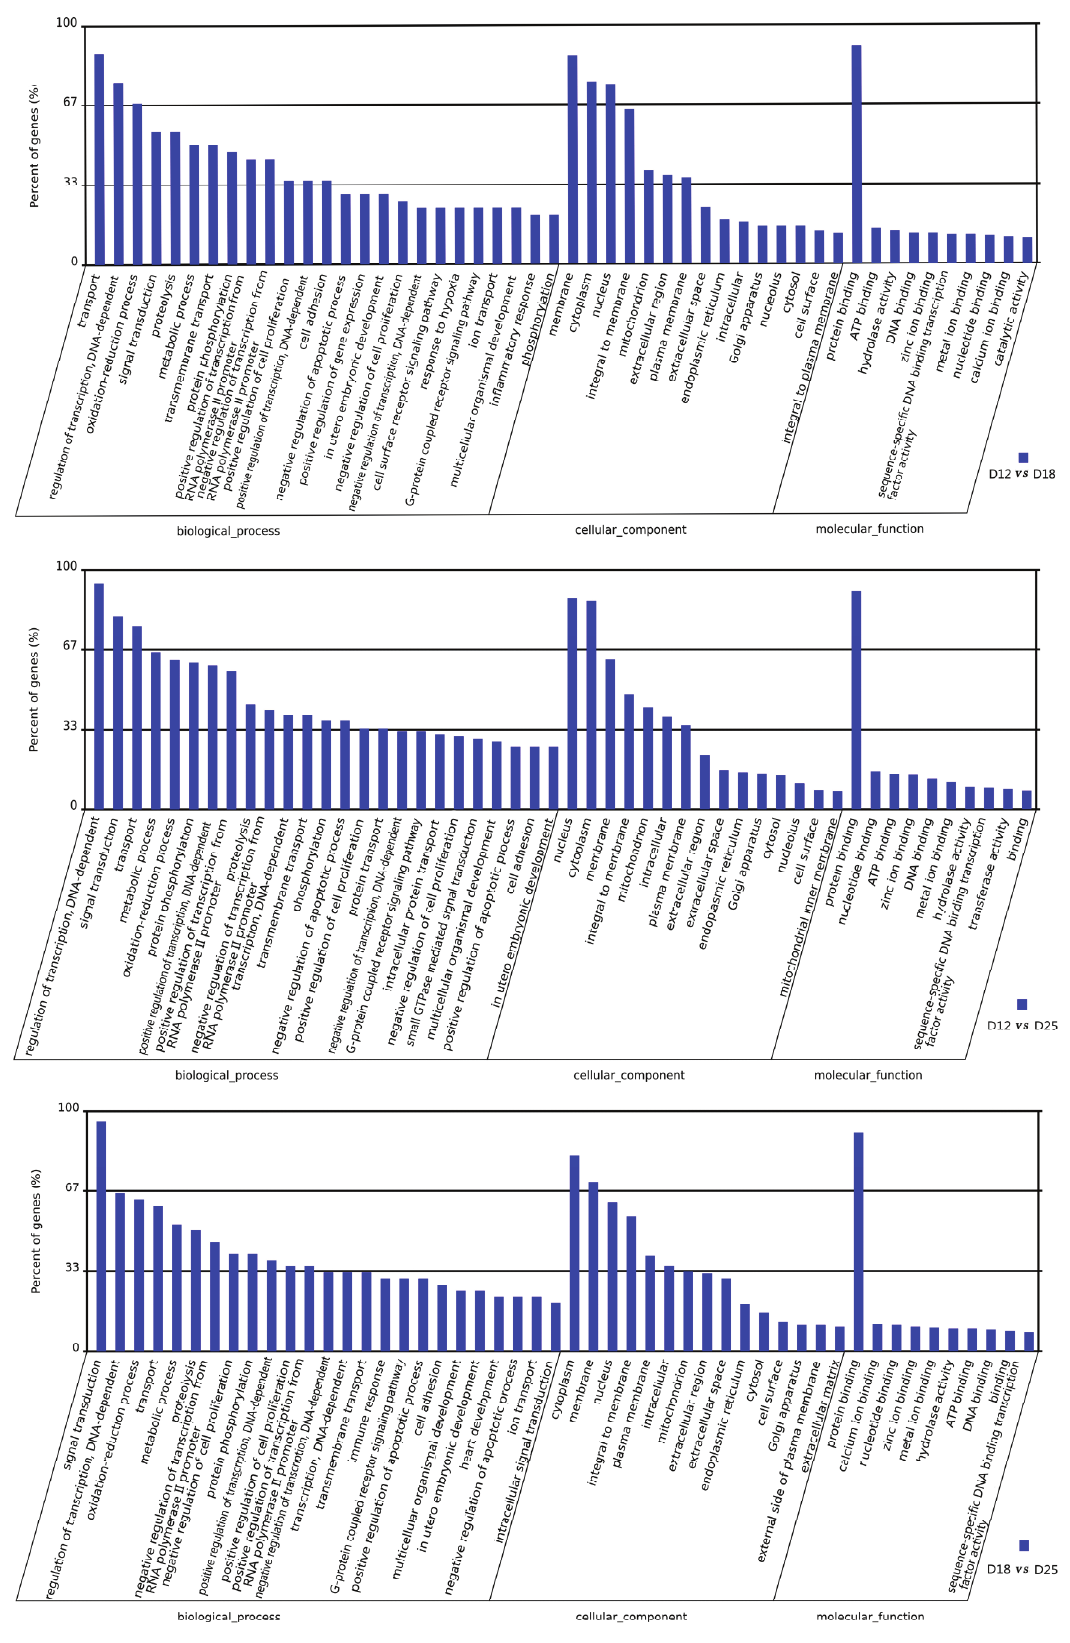
Figure 3. GO categories of the transcripts expressed differently between the three periods (days 12, 18, and 25) of pregnancy. Transcripts were annotated in three categories: cellular components, molecular functions, and biological